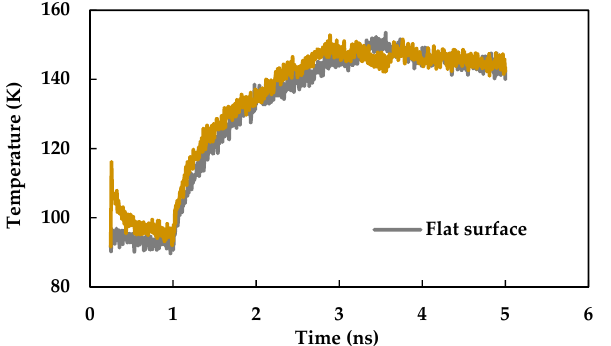
Figure 14. Snapshots from the simulation domain ( x – y plane) for ( a ) surface having nano slots, ( b ) smooth surface.